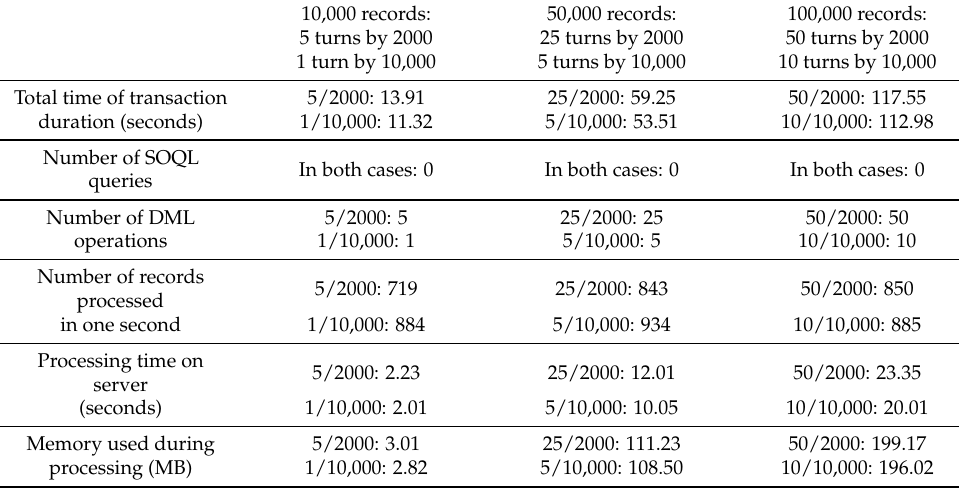
Table 7. Apex Queueable processing results for insert